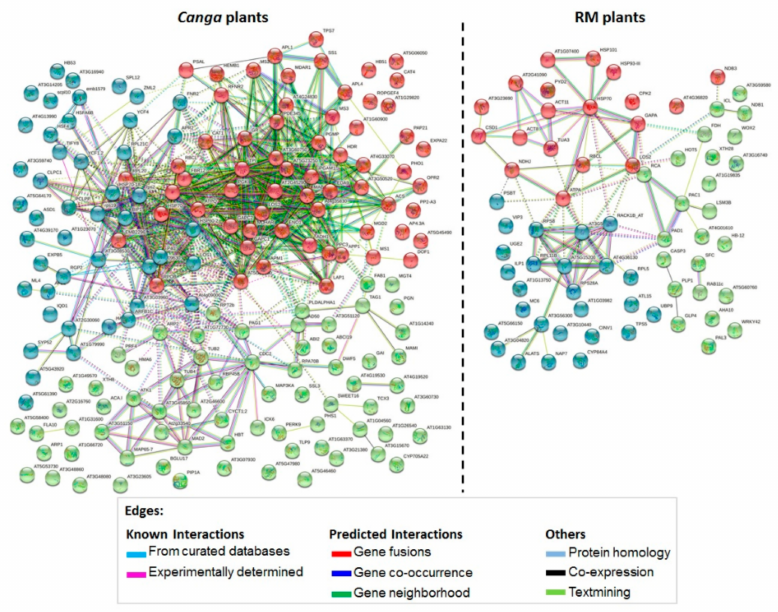
Figure 2. Protein–protein interaction network of the proteins with differential abundances in D. apurensis in canga (to the left) and RM (to the right) separated into 3 K -means clusters illus- trated in different colors. The proteins used for analysis are presented in Dataset S2. Gene symbols were obtained using homologous proteins from the Arabidopsis thaliana database from uniprot.org, accessed on 10 October 2021. Edges represent protein–protein interactions as described in the figure. Number of edges between in canga plants: 697. Number of edges between RM plants: 54. Dotted lines represent edges between clusters. PPI enrichment p -value in canga plants: 1 × 10 − 16 . PPI enrichment in RM plants: <1.4 × 10 − 6